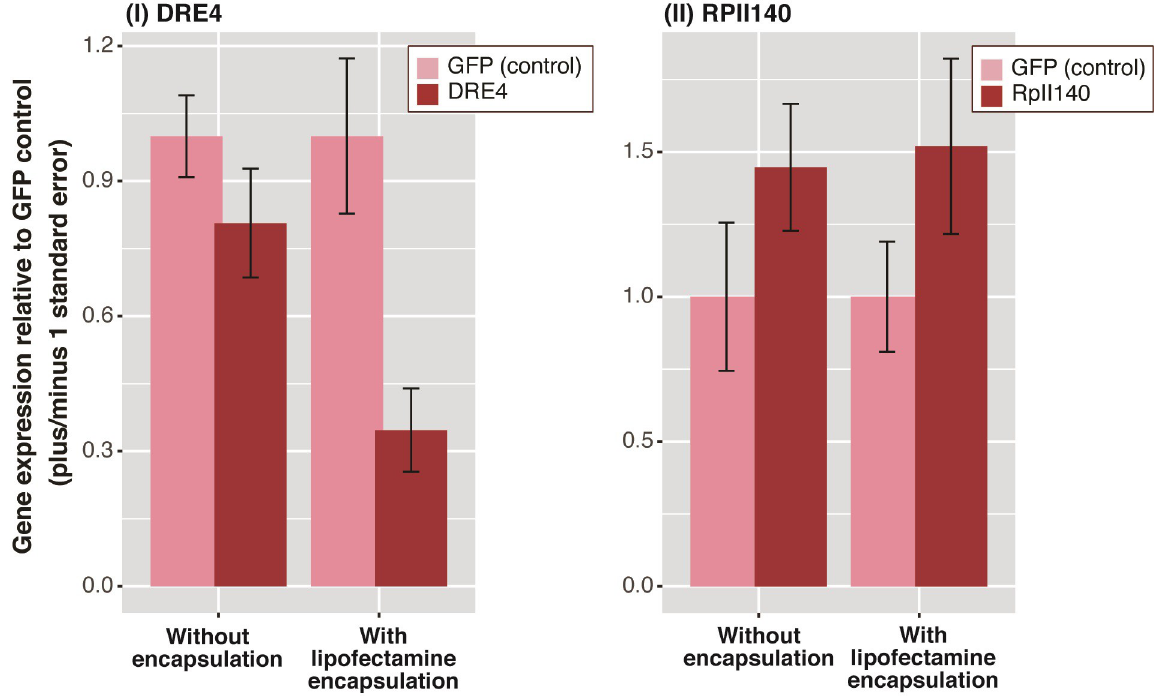
Fig 8. Relative gene expression for P . dominula foragers that fed on two gene targets: (I) DRE4 and (II) RPII140 dsRNA, with and without lipofectamine encapsulation. For the encapsulated dsRNA, each bar corresponds to the pooled mean ± SE of five wasps, compared to five GFP control wasps. For the unprotected dsRNA, each bar corresponds to the pooled mean ± SE for nine wasps, compared to the control treatment of nine wasps fed GFP dsRNA.